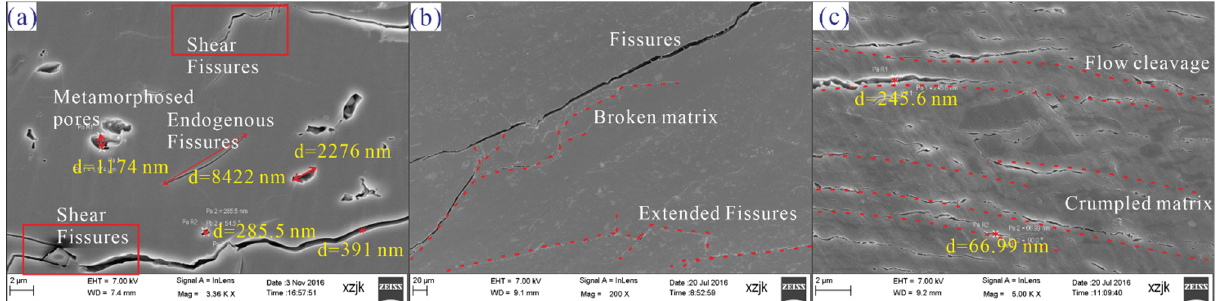
Figure 5. The morphology of pores and fissures in samples: ( a ) is the PUC sample; ( b ) is the BDC sample; ( c ) is the DDC sample.